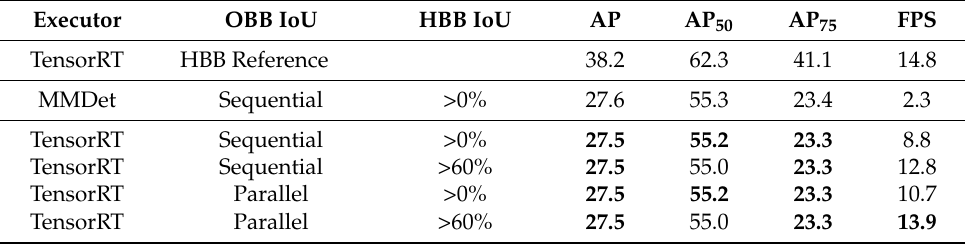
Table 15. Evaluating the impact of parallelizing the skew IoU computation and increasing the IoU threshold used for checking for a horizontal overlap. Without further optimizations, the NMS becomes a bottleneck when predicting OBBs and reduces the advantage of TensorRT and half- precision floating-point arithmetics. Parallelizing the skew IoU to increase the GPU utilization and only calculating the skew IoU if a significant horizontal IoU is given, increases the performance to a level close to HBB